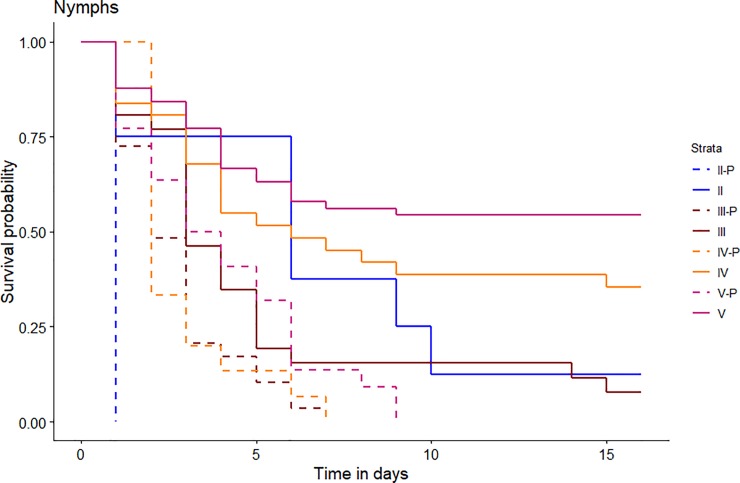
Comparison of cumulative survival of different stages (II, III, IV and V) of larvae of Sigara lateralis between those parasitized by Hydrachna skorikowi and those unparasitized.Individuals were maintained in water from the collection site (Dulce pond, 0.8 g/l). Stages represented are those for the beginning of the experiment, e.g. if a larva moulted from stage II to III before death, it is represented here as II.